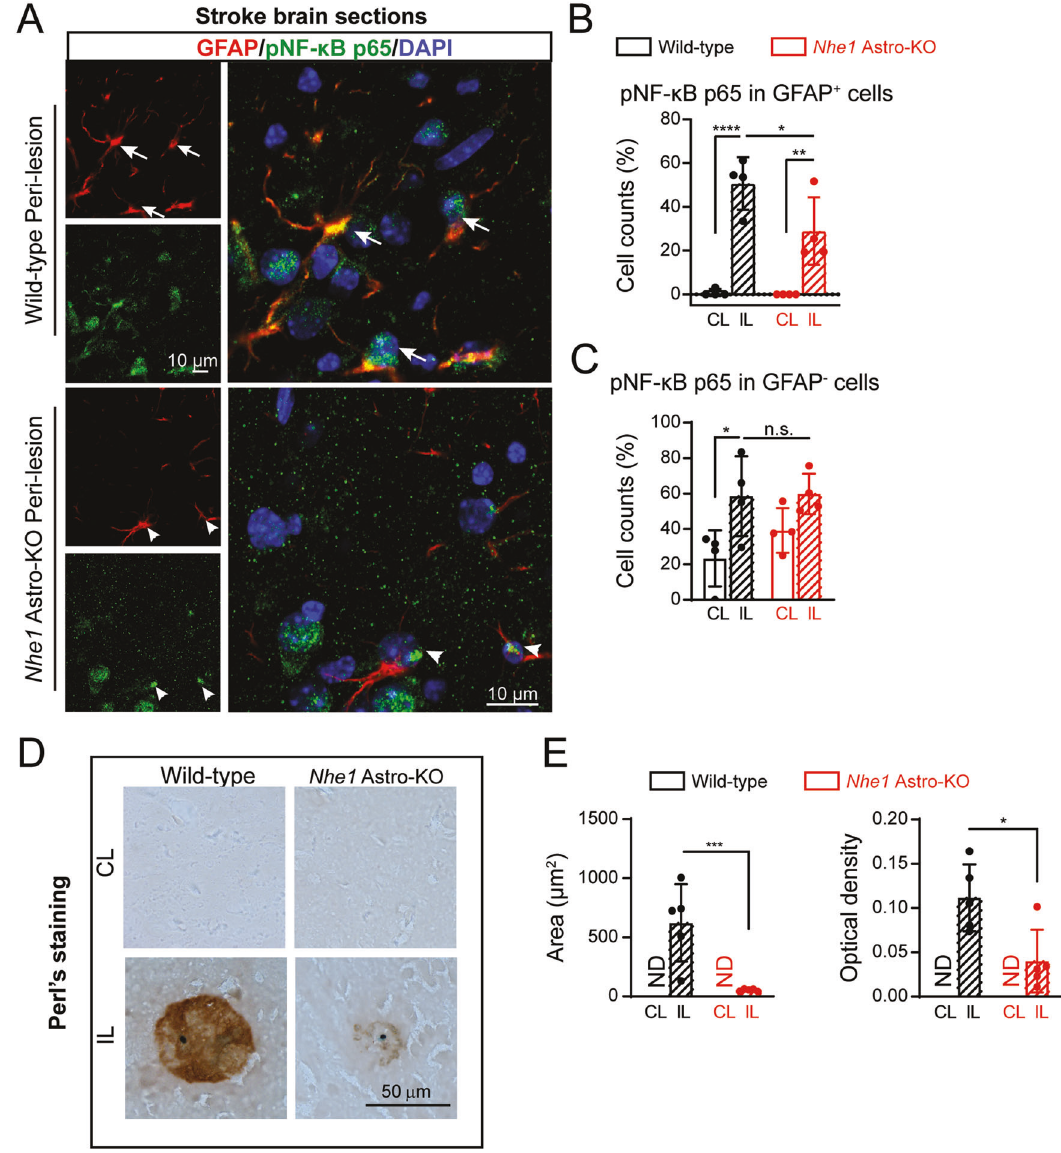
Fig. 7 Reduced astrocytic NF- κ B activation and decreased iron accumulation in astrocyte speci fi c Nhe1 deleted ischemic brains. A Representative confocal images of pNF- κ B p65 and GFAP expression in wild-type and Nhe1 Astro-KO brains at 48 h Rp. Arrows : high expression. Arrowheads: low expression. B Summary data shows quanti fi cation of pNF- κ B p65 + nuclear counts in GFAP + and GFAP - cells. Data are mean ± SD, n = 5. * p < 0.05; ** p < 0.01; *** p < 0.001; **** p < 0.0001 via one-way ANOVA. C Representative histochemical images stained for iron by enhanced Perl ’ s reaction. D , E Summary data shows quanti fi cation of the coverage ( D ) and optical density ( E ) of iron positive staining in the IL hemispheres of wild-type and Nhe1 Astro-KO brains at 48 h Rp. Data are mean ± SD, n = 5. * p < 0.05; ** p < 0.01; ** *p < 0.001; **** p < 0.0001 via one-way ANOVA and unpaired